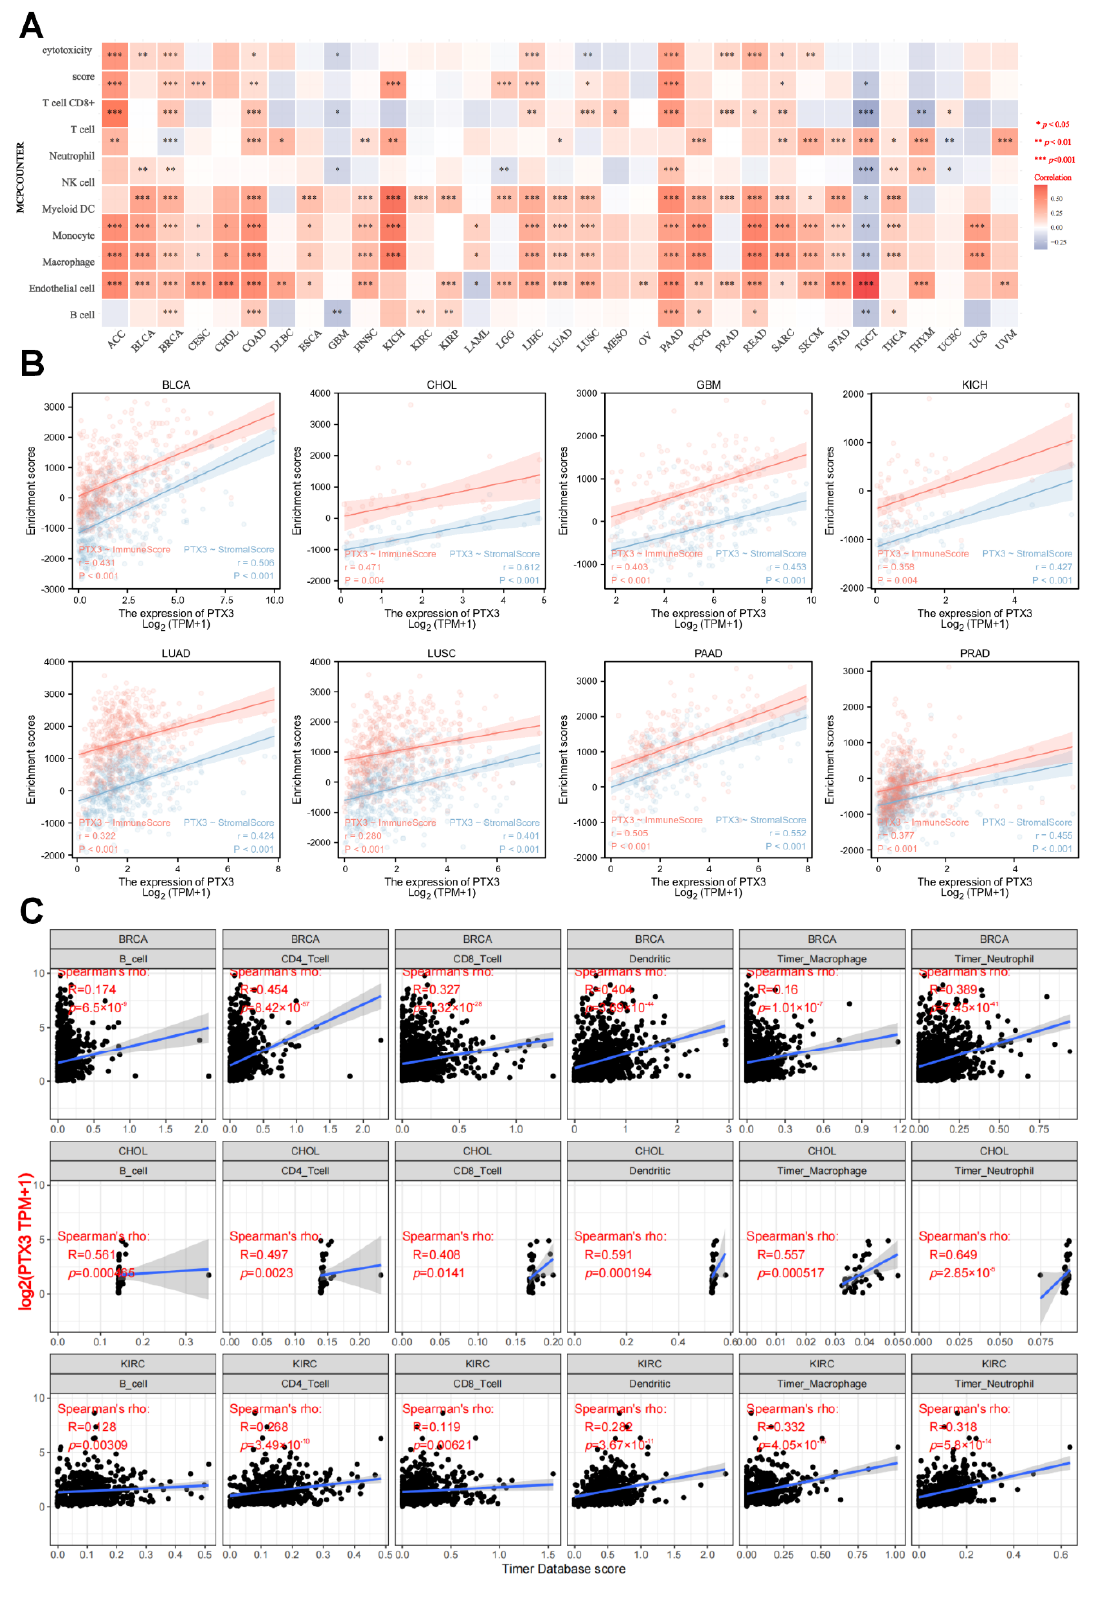
Figure 7. Immune analysis of PTX3: ( A ) Correlations between PTX3 and immune cells; ( B ) correla- tion between PTX3 and immune and stromal scores; ( C ) relationship between PTX3 and immune infiltration in the top three most related cancers.